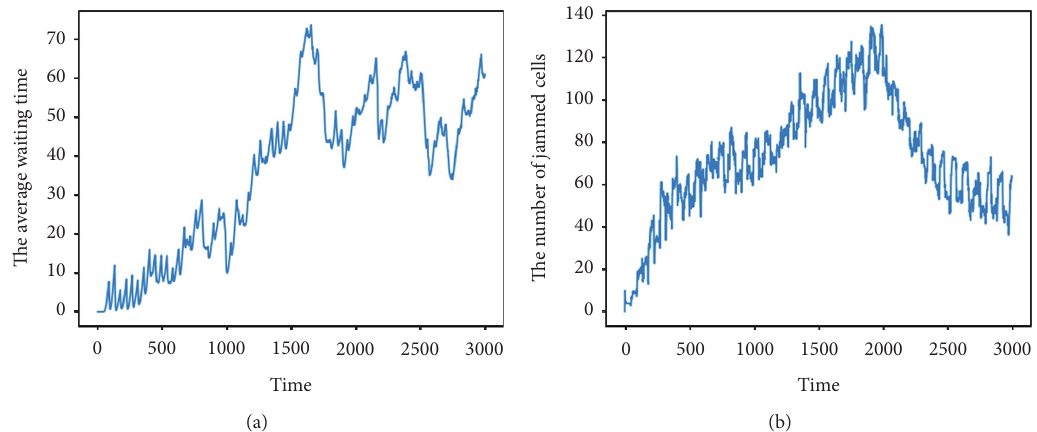
Figure 13: The number of jammed cells and vehicles’ waiting time of a 5 × 5 network with fixed time traffic lights. (a) Waiting time. (b) Number of jammed cells.